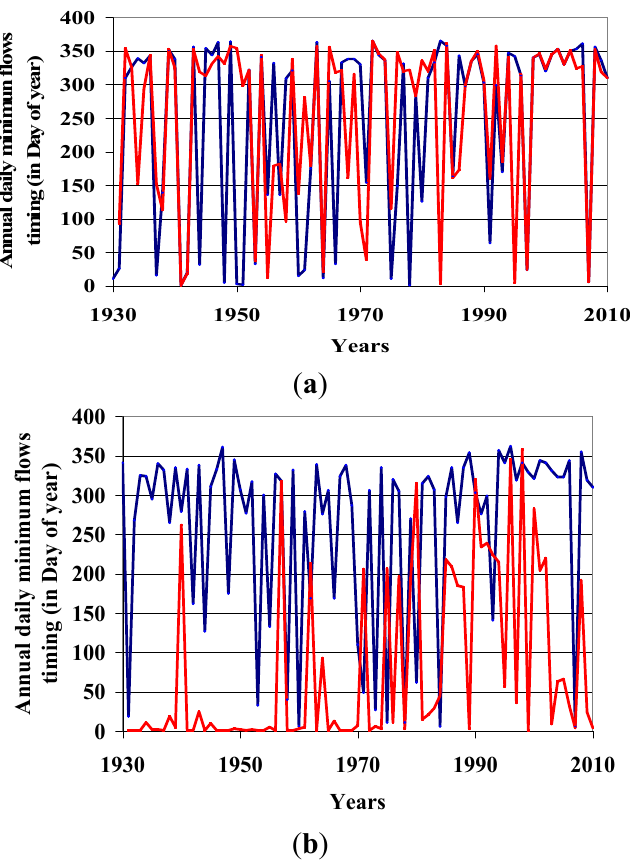
Figure 6. Comparison of the temporal variability of AMEF timing from the Matawin dam (red curve) from 1930 to 2010 ( a ) the L’Assomption River (blue curve) and Matawin River upstream; ( b ) the Ouareau River downstream from the Rawdon dam (blue curve) and in the Matawin River